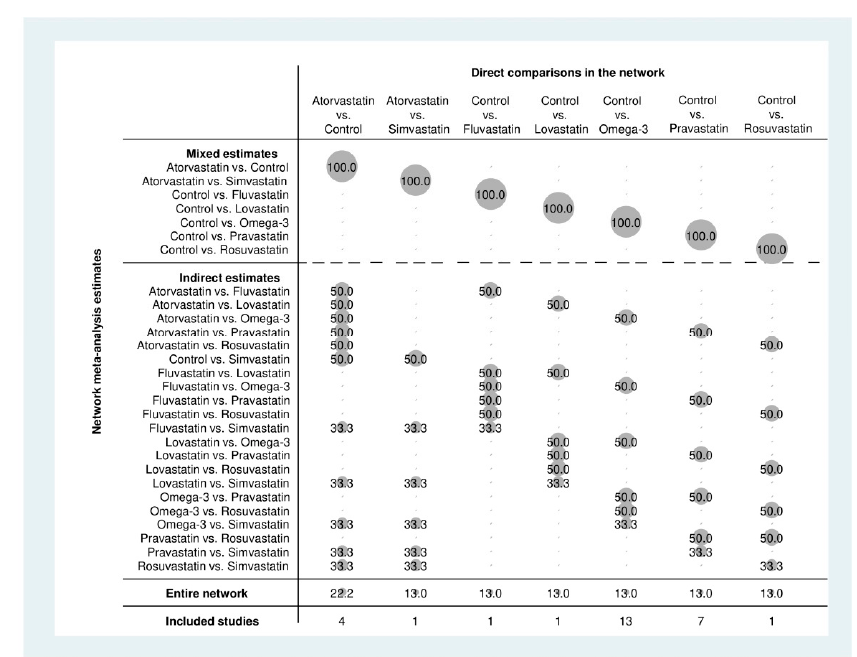
Figure A5. Contribution plot for the coronary heart disease network. The size of the square is weighted as the percentage (as number) of the contribution of the direct estimate (horizontal axis) to the network estimate (vertical axis).